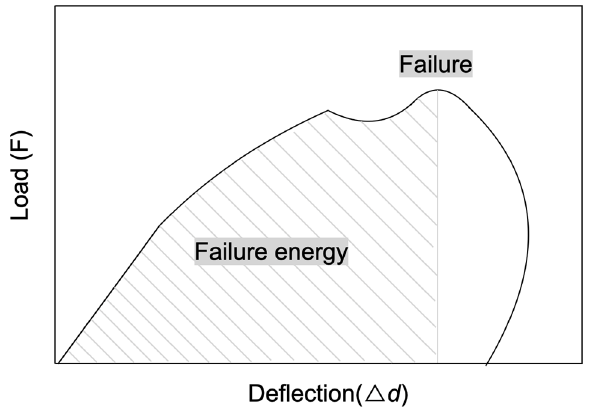
Figure 7. Identification of D ‐ load, D ‐ peak and D u from a force ‐ deflection curve of an RCP.